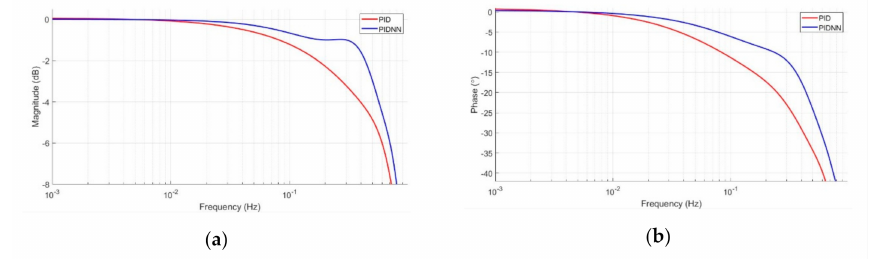
Figure 13. Driving capacity as frequency changes: ( a ) magnitude variation in angle tracking; ( b ) phase variation in angle